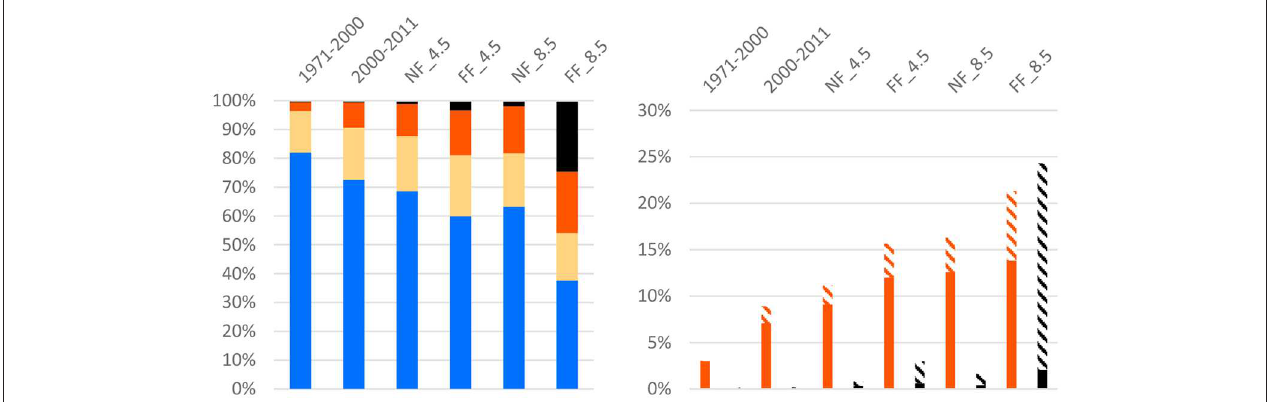
FIGURE 7 | Shares of river reaches with different levels of TR-PKD in Austrian rivers; Left panel: No outbreak (blue), possible outbreak (yellow), low mortality (orange), high mortality (black). Combined effects of TR-PKD and physiological thresholds; Right panel: Low mortality and diminished growth (orange striped), high mortality and cardiac dysfunction (black striped). With Scenarios: Past = 1971–2000, Current conditions = 2000–2011, and abbreviations for the different scenarios: NF, near future; FF, far future; 4.5 = RCP4.5 and 8.5 = RCP8.5 (8.5).